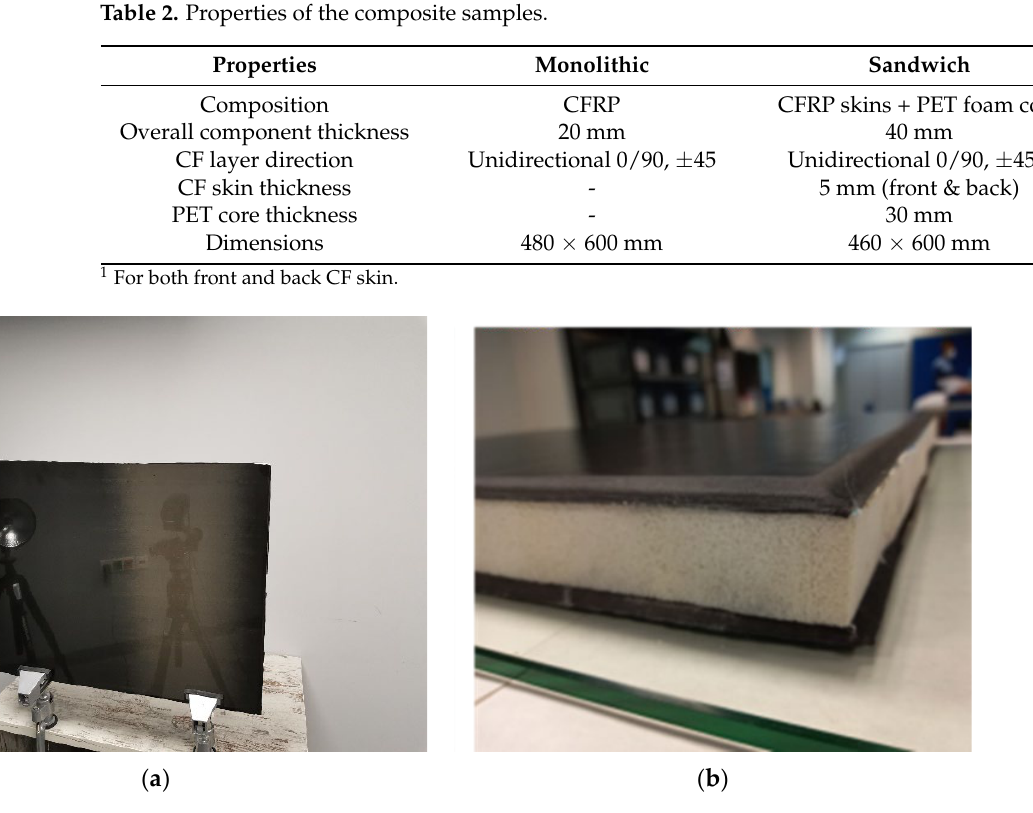
Figure 1. Photos of the CF-PET-CF sandwich sample: ( a ) very smooth low emissivity inspection side and ( b ) side view presenting the foam core and CF skins.